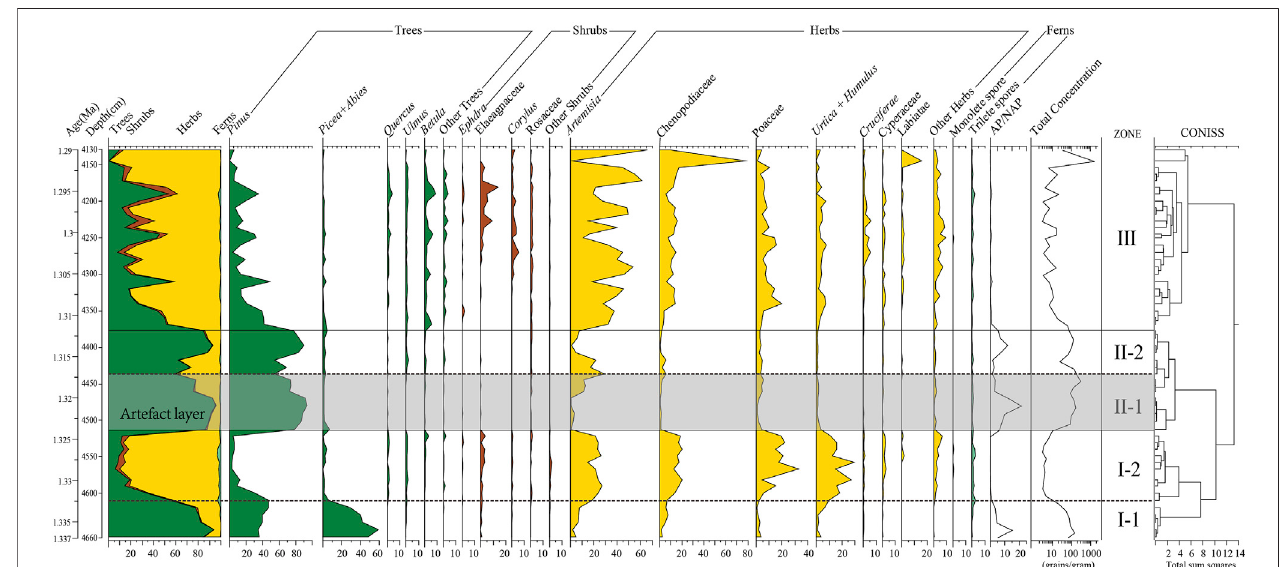
FIGURE 3 | Pollen percentage and concentration diagram for the Banshan site. Only selected taxa are shown. CONISS results are shown on the far right.